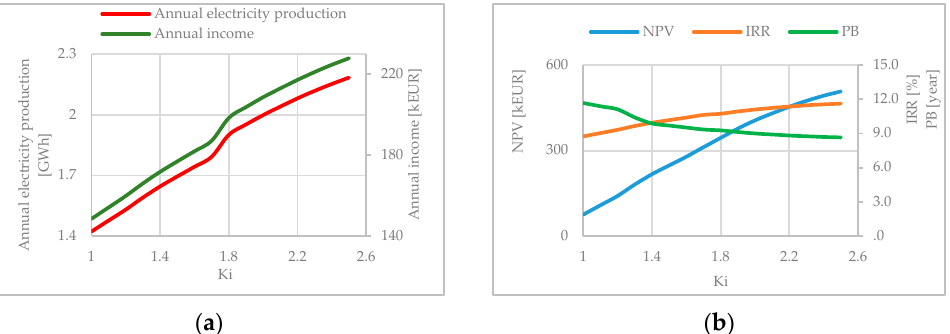
Figure 2. ( a ) Annual electricity production and income—Hridska SHPP; ( b ) NPV, IRR, and PB— Hridska SHPP.